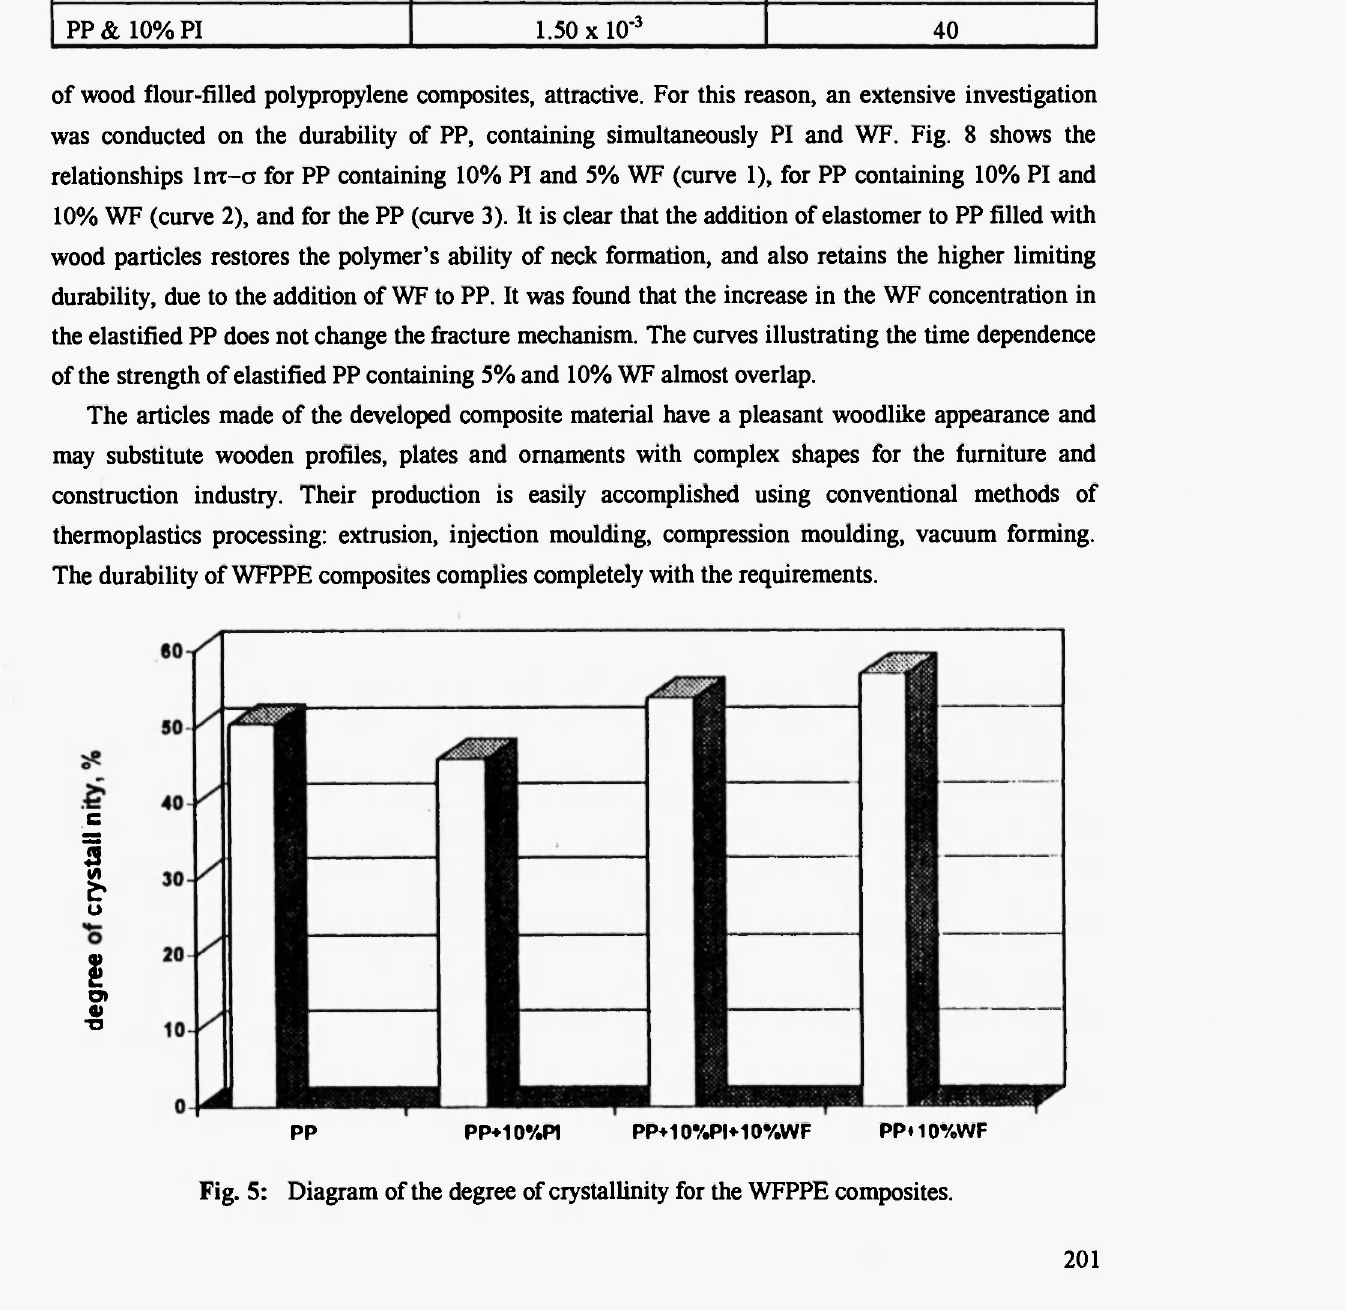
Fig. 5: Diagram of the degree of crystallinity for the WFPPE